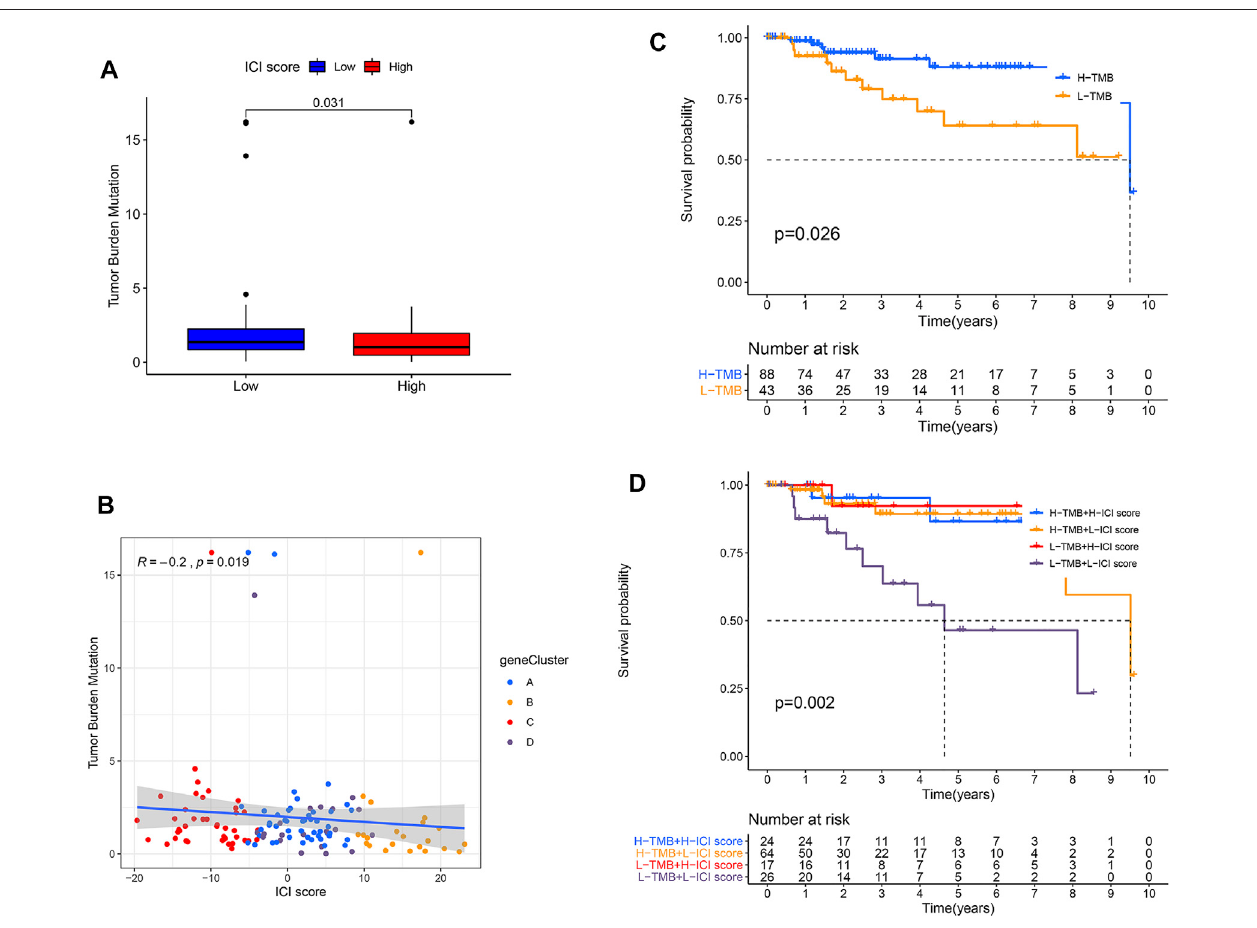
FIGURE 4 | Combination of ICI and TMB scores to predict prognosis in TNBC. (A) Compared TMB level between two ICI score subgroups. p = 0.031. (B) Correlation between ICI and TMB scoresin four gene clusters. Spearmantest, correlation coef fi cient (R)= − 0.2, p = 0.019. (C) OS curves for high- and low-TMB groups of the TCGA-TNBC cohort. p = 0.026. (D) KMA for patients in the TCGA-TNBC cohort was strati fi ed by both TMB and ICI scores. p =